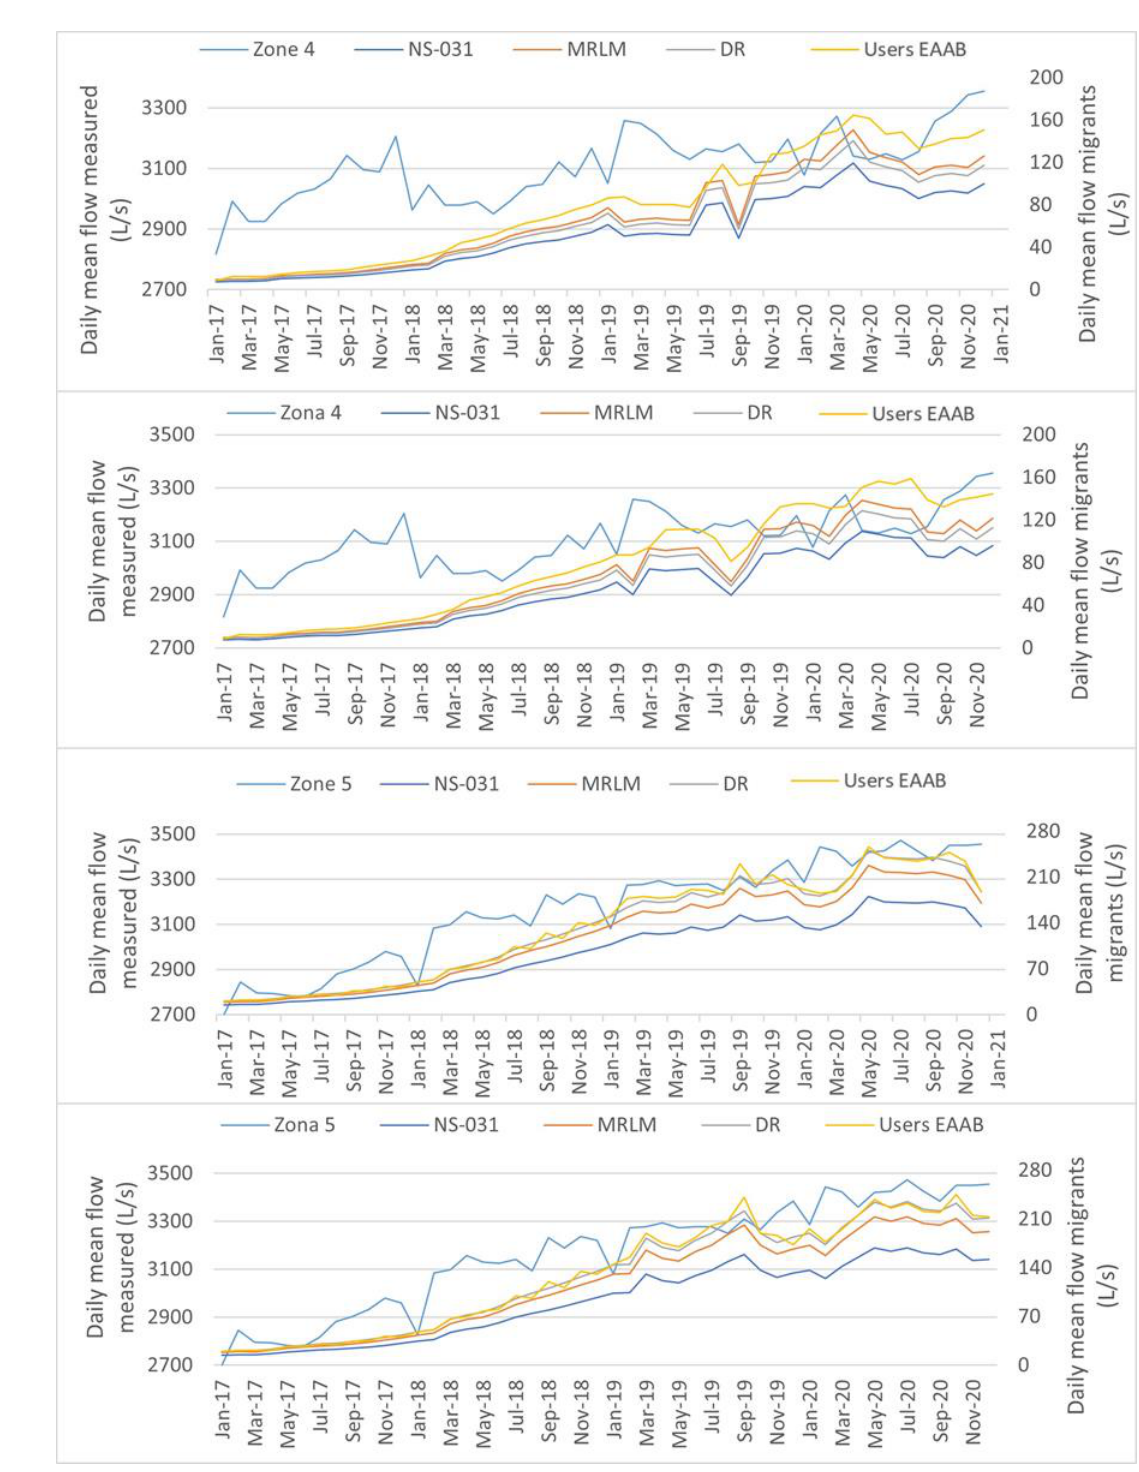
Figure 9. Monthly daily mean flow left and migrant consumption right ( a ) Zone 4 by the mathematical approach; ( b ) Zone 4 by the statistical approach; ( c ) Zone 5 by the mathematical approach; ( d ) Zone 5 by the statistical approach.